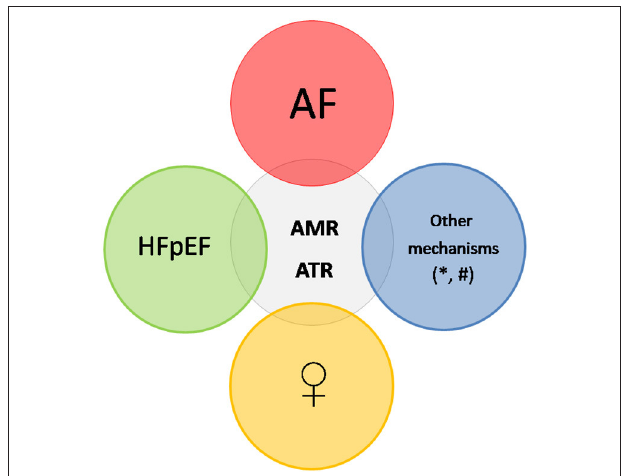
FIGURE 1 | Differents factors contribute to the occurrence of AMR and ATR. The most frequent substrate is AF, which leads to atrial and atrioventricular annulus dilation. HFpEF also elicits AMR and ATR, due to left and right atrial dilation as a result of pressure overload, and also constitutes a frequent trigger for AF. * denotes other variables or mechanisms, which may contribute to the occurrence of AMR, like hypervolemia, hamstringing of the posterior mitral leaflet or insufficient leaflet growth. # denotes other variables or mechanisms, which may contribute to the occurrence of ATR, like older age, hypervolemia, pulmonary hypertension, intracardiac lead or insufficient leaflet growth. Prevalence data and suggested pathophysiologic mechanisms indicate that female patients are at higher risk for these heart valve disorders. AMR, atrial mitral regurgitation; ATR, atrial tricuspid regurgitation; AF, atrial fibrillation; HFpEF, heart failure with preserved ejection fraction; PH, pulmonary